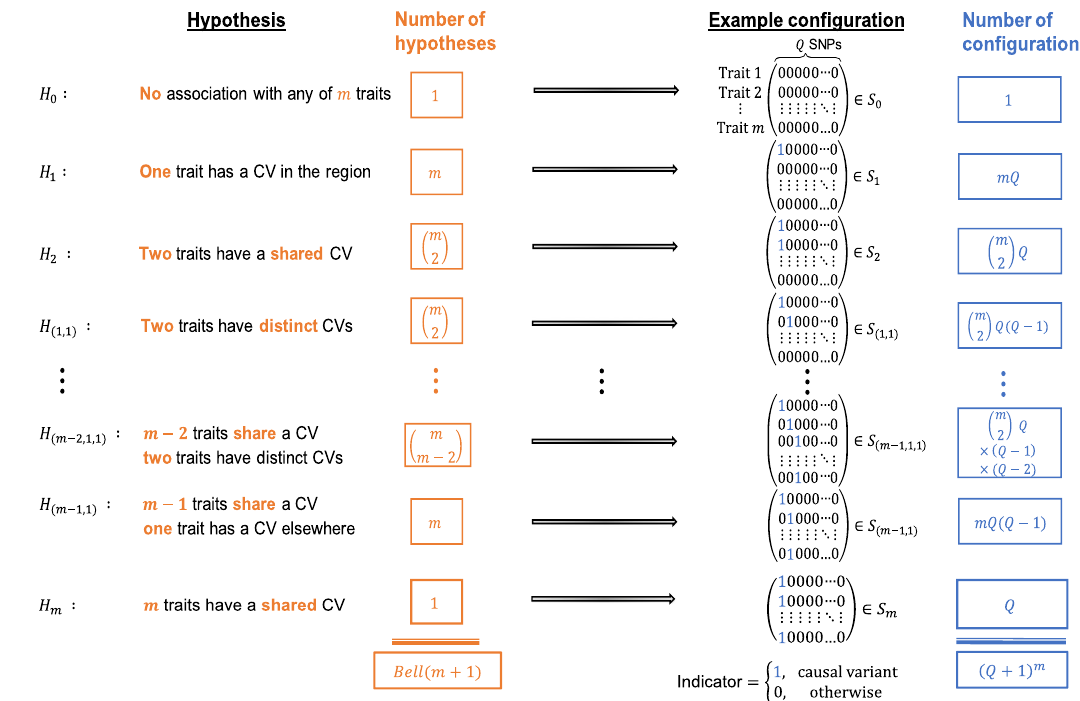
Fig. 1 Colocalization hypotheses and causal con fi gurations. Statistical colocalization hypotheses and examples of their associated SNP con fi gurations that allow for at most one causal variant for each of m traits in a region containing Q genetic variants. For clarity, the hypotheses and a single con fi guration associated with each hypothesis are shown for m ≥ 4 traits, but the column totals Bell ( m + 1) and ( Q + 1) m are correct for m ≥